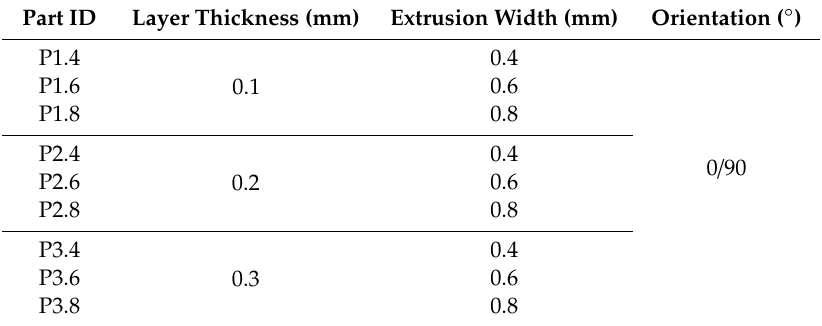
Table 3. Operational parameters for 3D printed